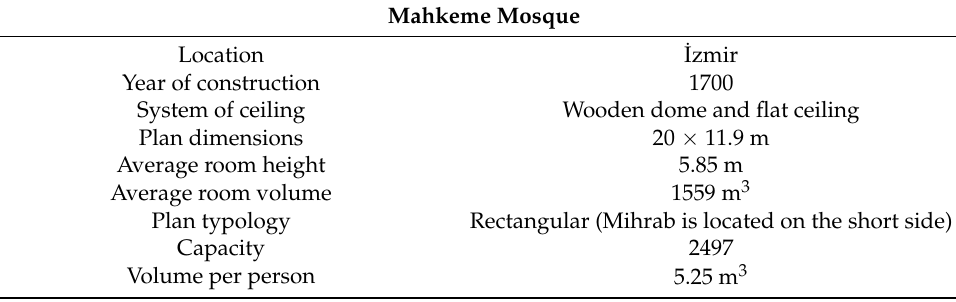
Table 6. The architectural features of Mahkeme